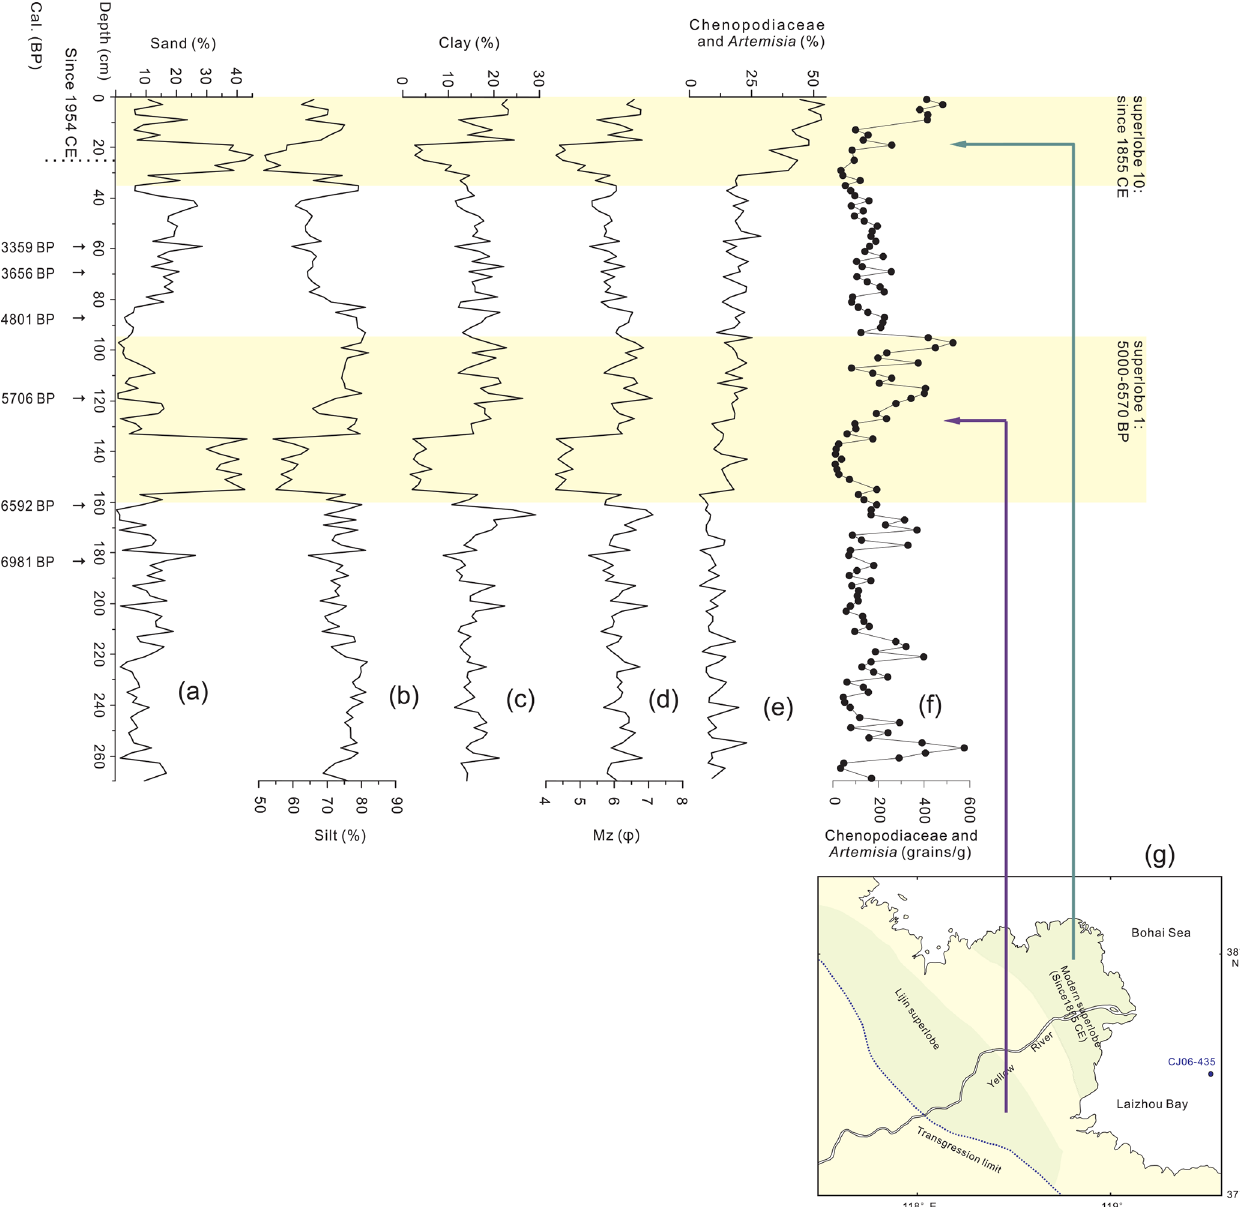
Figure 7. (a–f) Vertical profiles of grain size parameters and halophytic and xerophytic herb (Chenopodiaceae and Artemisia ) pollen per- centages and concentrations in core CJ06-435 (Mz stands for mean grain size). (g) The location of Yellow River superlobe 1 (Lijin superlobe) and superlobe 10 (modern superlobe) (modified following Xue,